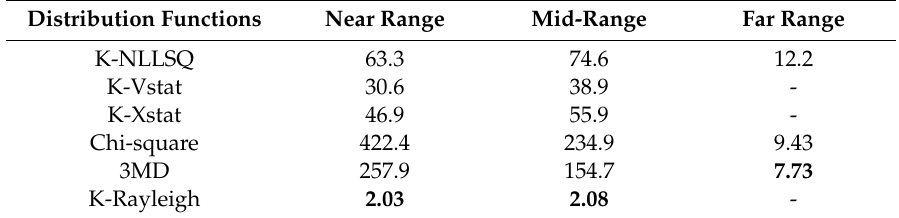
Table 6. False alarm rate errors for circularly acquired data. The values in the table are the ratio between the estimated actual false alarm rate and the set false alarm rate of 10 − 6